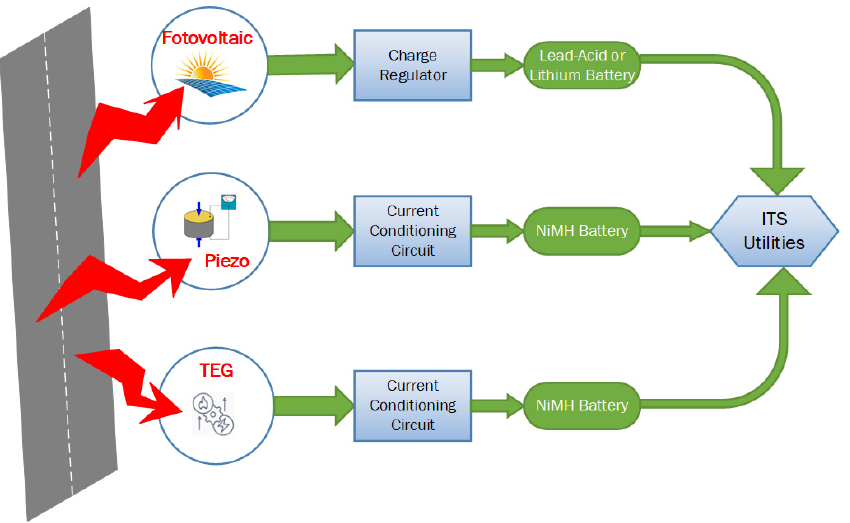
Figure 3. Schematic representation of the energy storage systems for ITS utilities, through energy harvesting pavements.